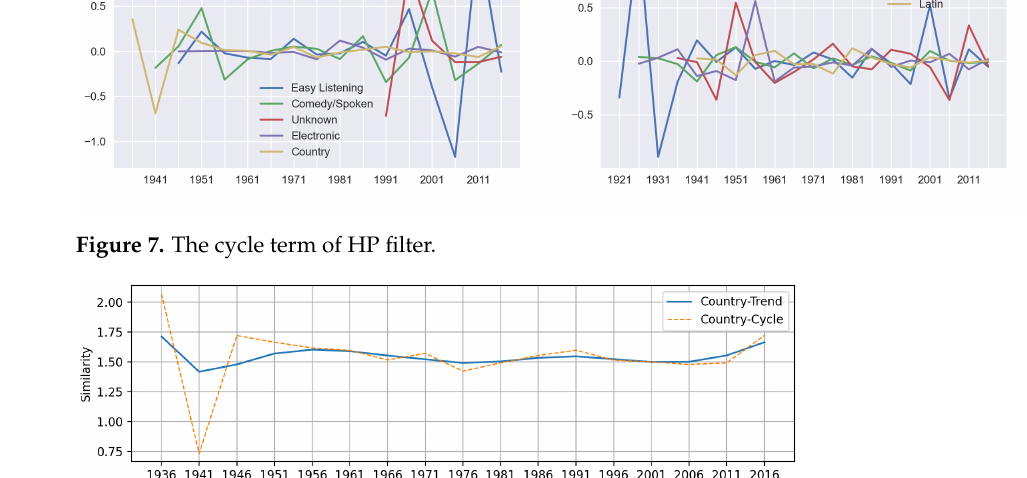
Figure 8. The cycle term of HP